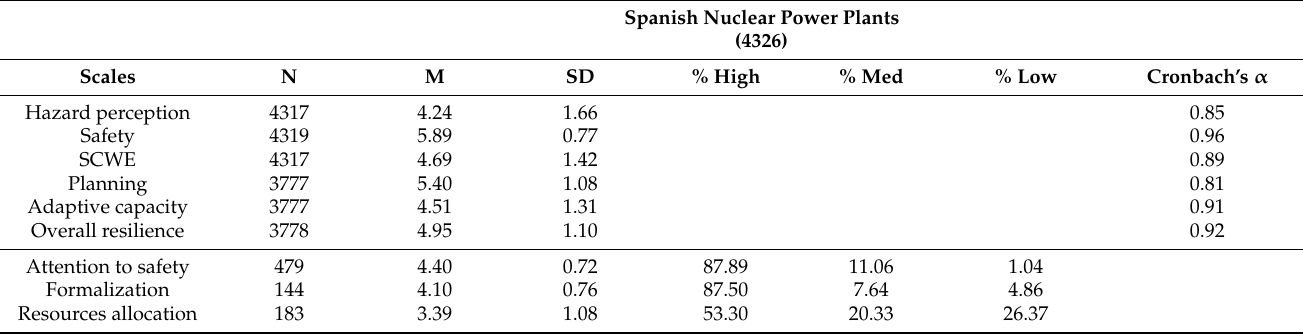
Table 3. Reliability and descriptive statistics of scales for the Spanish nuclear power plants.